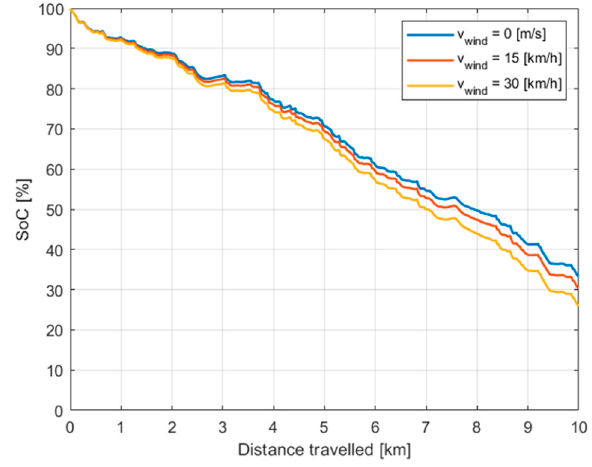
Figure 2. State of charge of the battery vs. distance